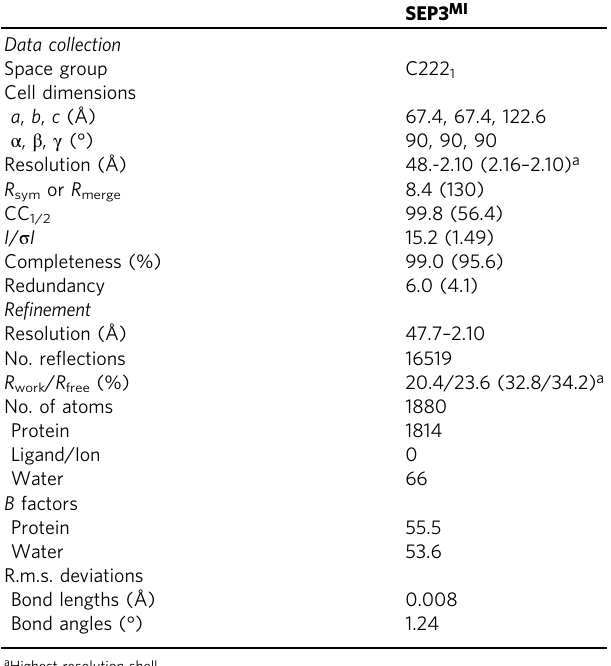
Table 1 Data collection and re fi nement